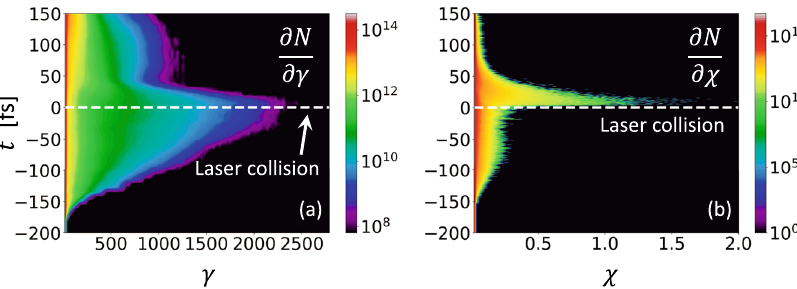
Fig. 3 Growth and collapse of the electron γ and χ as the laser collision occurs. Time evolution of the distributions of the a electron relativistic factor γ and b quantum nonlinearity parameter χ , de fi ned by Eq. (1), for the 2D PIC simulation shown in Fig. 1. The two laser pulses have a 0 = 190 and collide at t = 0, which is shown by the horizontal dashed